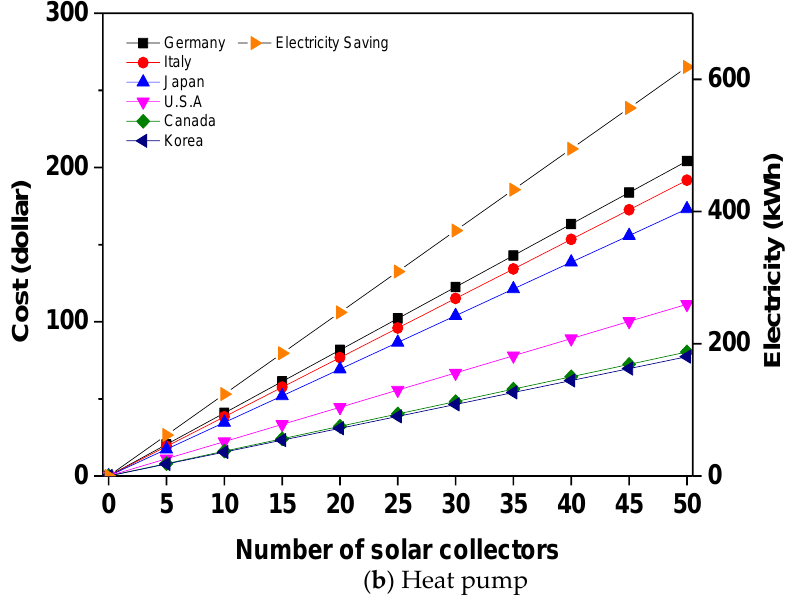
Figure 7. Electricity and electricity cost of the electric heater and heat pump using a flat-plate solar collector: ( a ) Electric heater; ( b ) Heat pump.